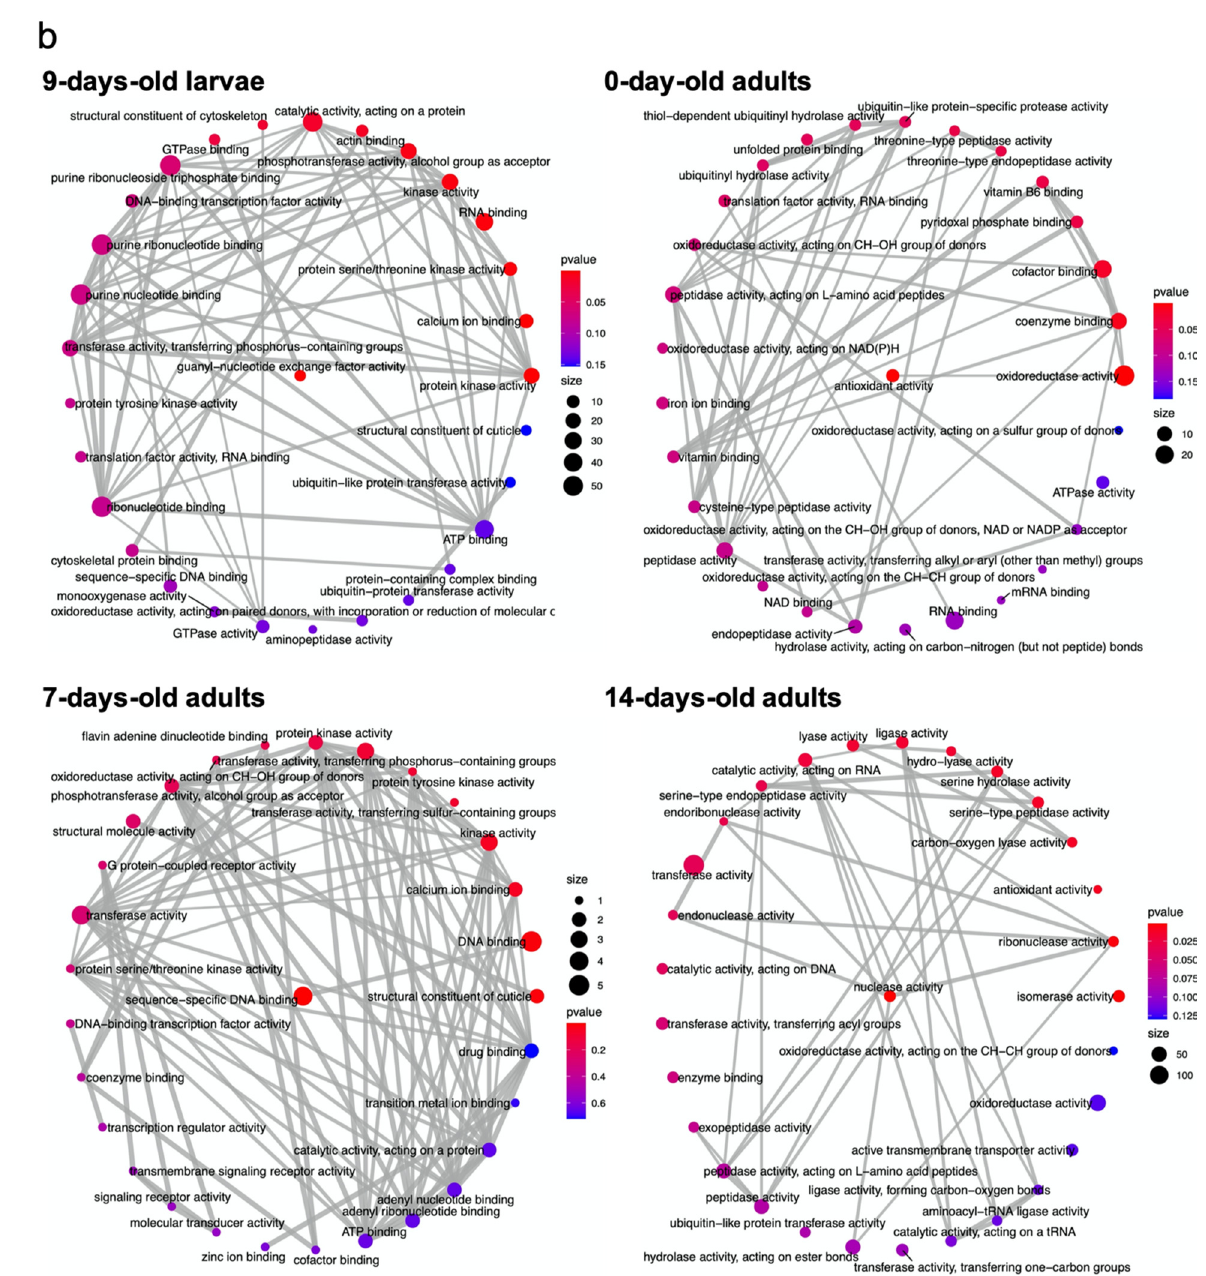
Figure 3. Enrichment maps for overrepresentation testing for GO terms in the pool of ( a ) upregulated and ( b ) downregulated DEGs among different imidacloprid treatments in 9-day-old larvae, 0-day-old adults, 7-day-old adults, and 14-day-old adults. Size: number of DEGs; p value: the p value of identified GO terms. The color from red to blue represents the p value from low to high. Gray lines indicate the network connection, and the weight of the line reflects the degree of connection between terms.